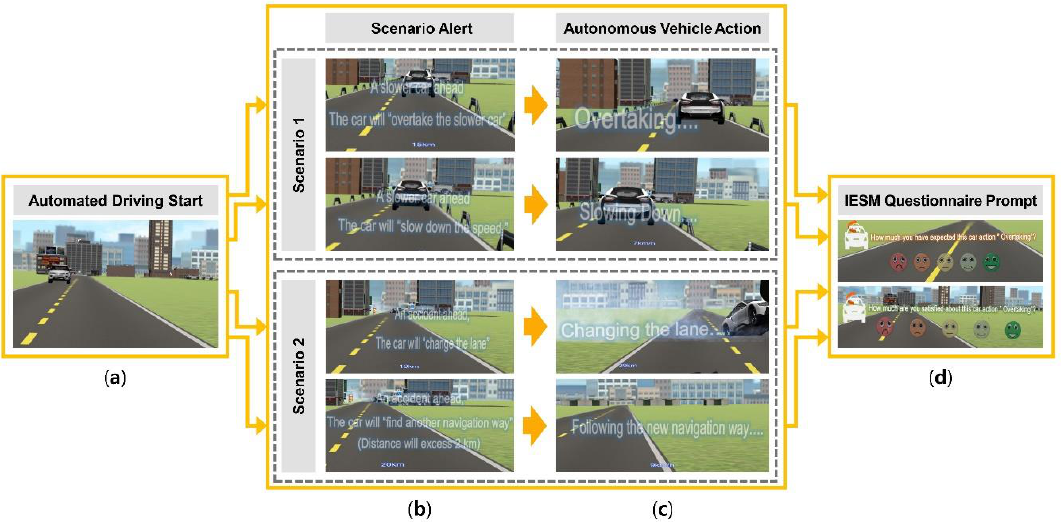
Figure 2. Illustration of our experiment scenarios sequence. ( a ) The main road view where the AV starts moving; ( b ) scenario alert (notification message shown on HUD to explain the current scenario to the participant before it starts performing the action); ( c ) AV scenario action (a notification message shown on HUD while the action occurs); ( d ) two immediate experience sampling questions were shown on HUD immediately after the completion of each action.